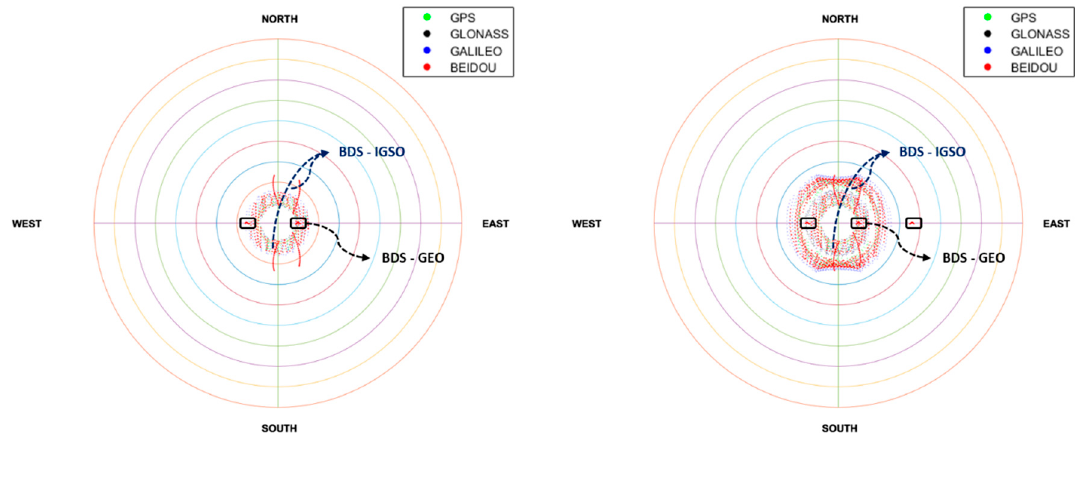
Figure 8. Sky-plot for 24 h when looking at the nadir in GEO. The results of GDOP simulation for 24 h at a geostationary orbit of 128 ◦ E longitude are shown in Figure 9 as an example. The mean of the GDOP for multi-GNSS using only the main lobe signal and with the side lobe signal together was 134.04 and 12.84, respectively. Most of the single system using only the main-lobe signal failed to obtain a suitable GDOP because the number of visible satellite or GDOP value did not satisfy the minimum conditions. In this scenario, GDOP over the threshold of 1000 is excluded.